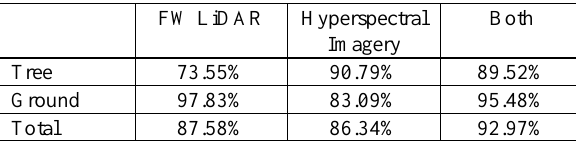
Table 12. Classification accuracy of each test case